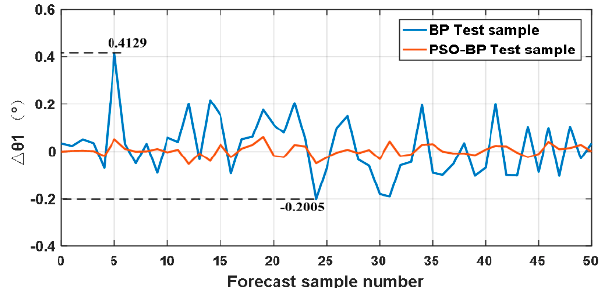
Figure 7. Error contrast of test set’s θ 1 .